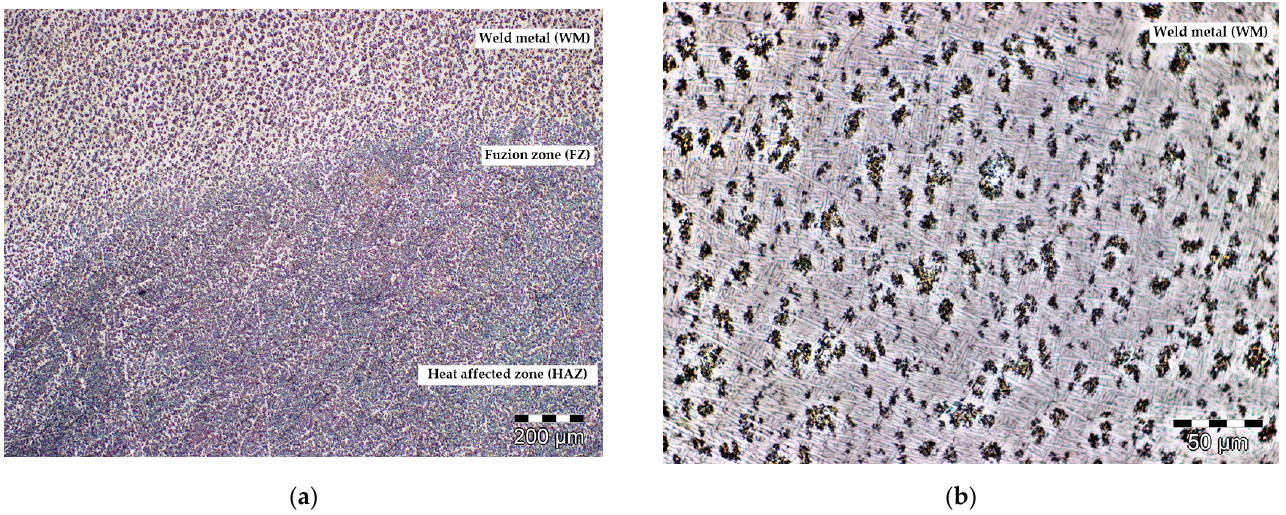
Figure 10. Microscopy image of the hip prosthesis reconditioning zone: ( a ) 100×; ( b ) 50×.